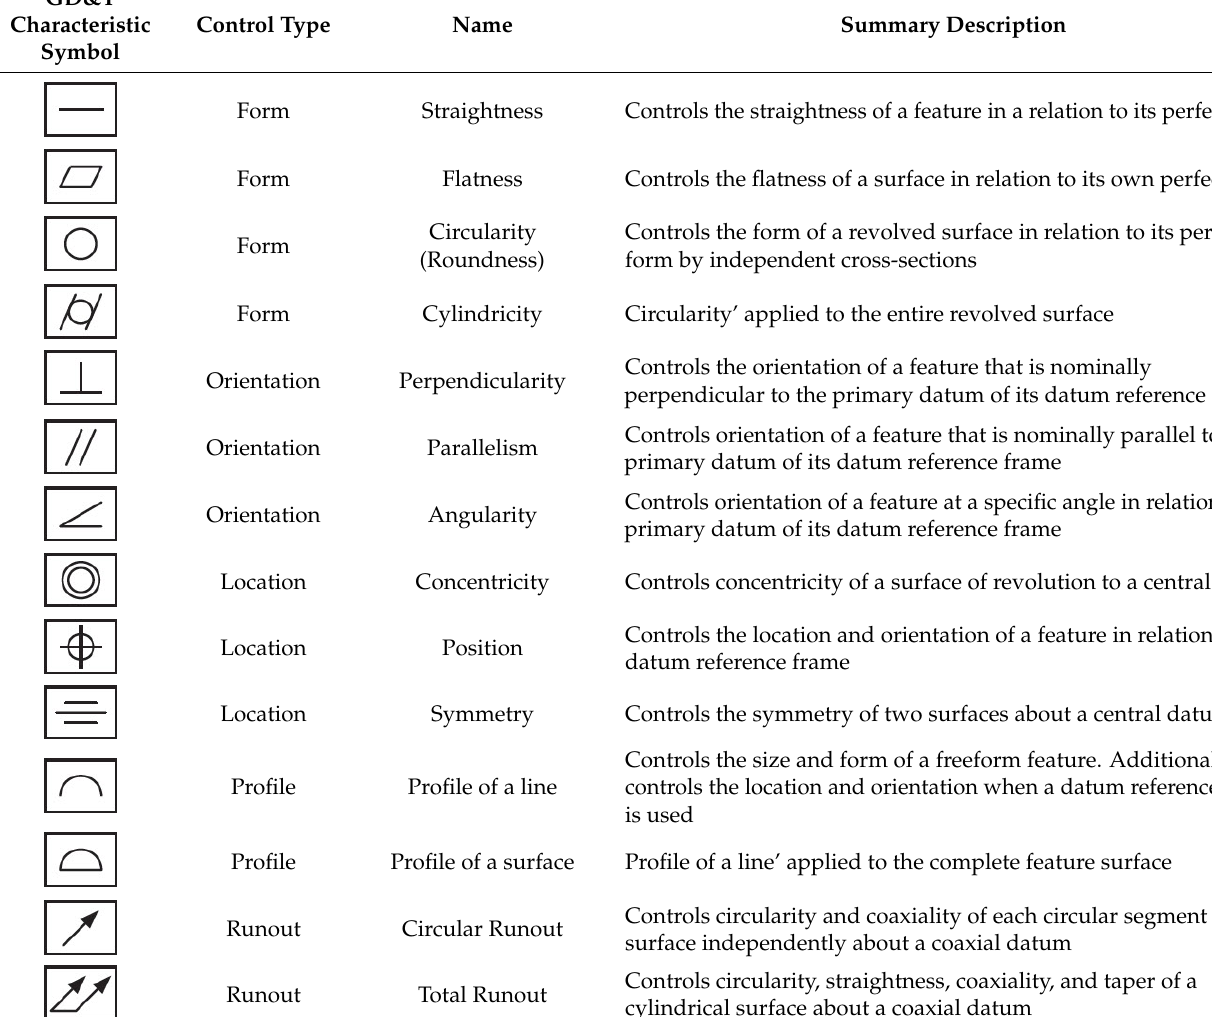
Table A1. GD&T characteristics, symbols and corresponding descriptions.